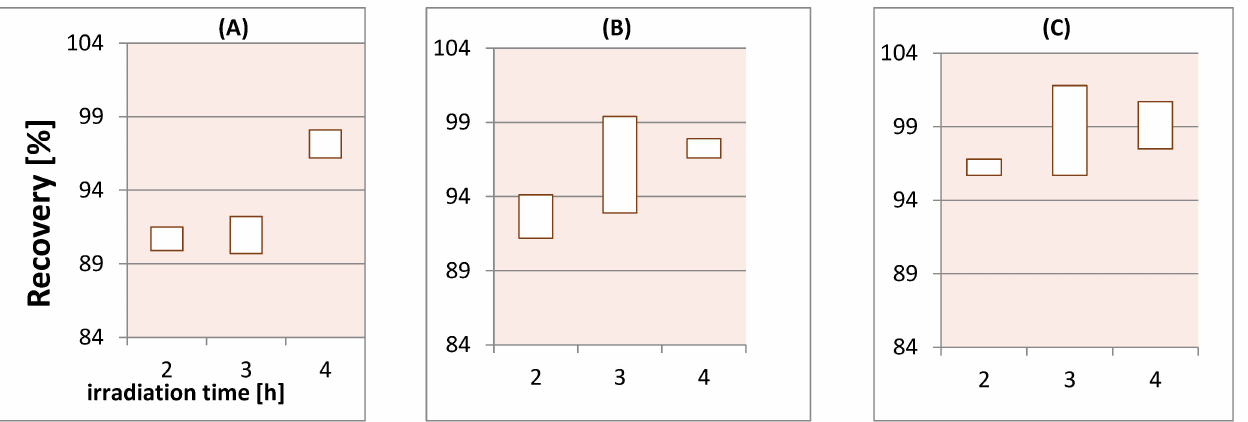
Figure 2. Comparison of the recoveries (in %) of the addition of 20 ng Pb in 23 mL solution of Triton solution with a concentration of 1.97 × 10 − 5 mol L − 1 from the irradiation time of 23 mL for the active layer with a structure: ( A ) Fe 2 O 3 /WO 3 /Fe 2 O 3 (pH = 5), ( B ) WO 3 /Fe 2 O 3 /WO 3 (pH = 2), ( C ) Fe 2 O 3 WO 3 /Fe 2 O 3 WO 3 /Fe 2 O 3 WO 3 (pH = 2) (unpublished